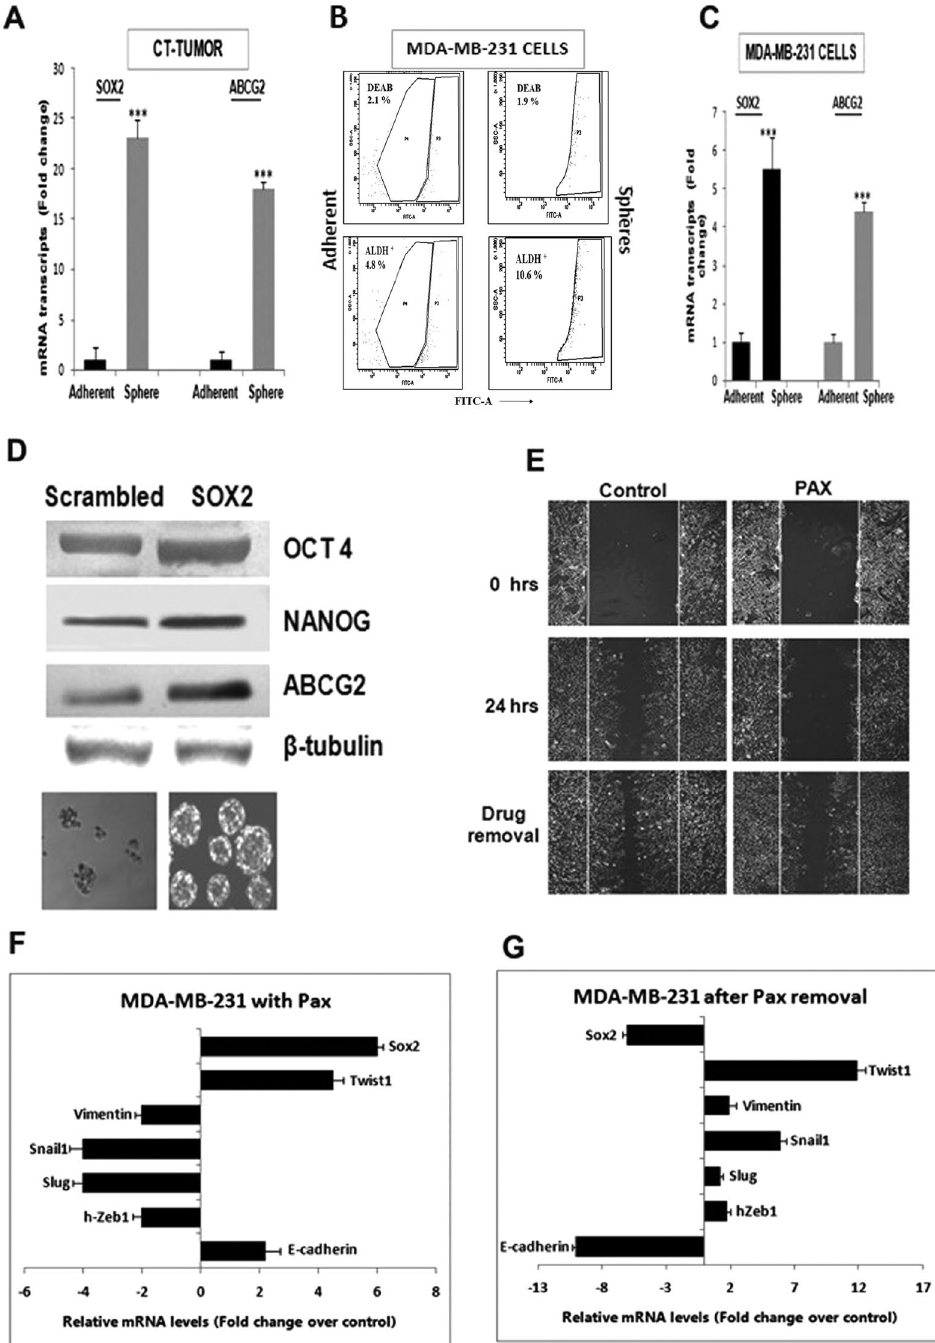
Figure 4. SOX2 is correlated to chemoresistance gene ABCG2 and EMT marker TWIST. ( A ) Higher expression of SOX2 and ABCG2 mRNAs in mammospheres from triple negative breast tumors compared to primary adherent cells from the same chemo-treated (CT) tumor (p < 0.001). ( B ) MDA-MB-231 cells showed a higher ALDH + population in mammospheres compared to adherent cells. ( C ) Higher expression of both SOX2 and ABCG2 was observed in mammospheres developed from MDA-MB-231 cells (p < 0.001). ( D ) Over-expression of SOX2 in MDA-MB-231 cells led to increased expression of OCT4, NANOG and ABCG2 protein, along with robust formation of spheres. β -tubulin was used as the loading control. ( E ) Wound healing assays in MDA-MB-231 cells for 24 hours of Pax treatment (2 nM). Migration of treated cells compared to control after 24 hours of drug removal is shown in the bottom panel. ( F ) Migratory properties indicated by mRNA expression show up regulation of SOX2, OCT4, WNT, ABCG2, TWIST1, E-CADHERIN and down regulation of mesenchymal markers VIMENTIN, SNAIL, SLUG1, hZEB1 after Pax treatment of MDA-MB-231 cells. ( G ) Drug removal showed a decrease in the mRNA expression of all pluripotency genes along with E-CADHERIN and a simultaneous increase in the mesenchymal markers. TWIST1 expression remained high under both